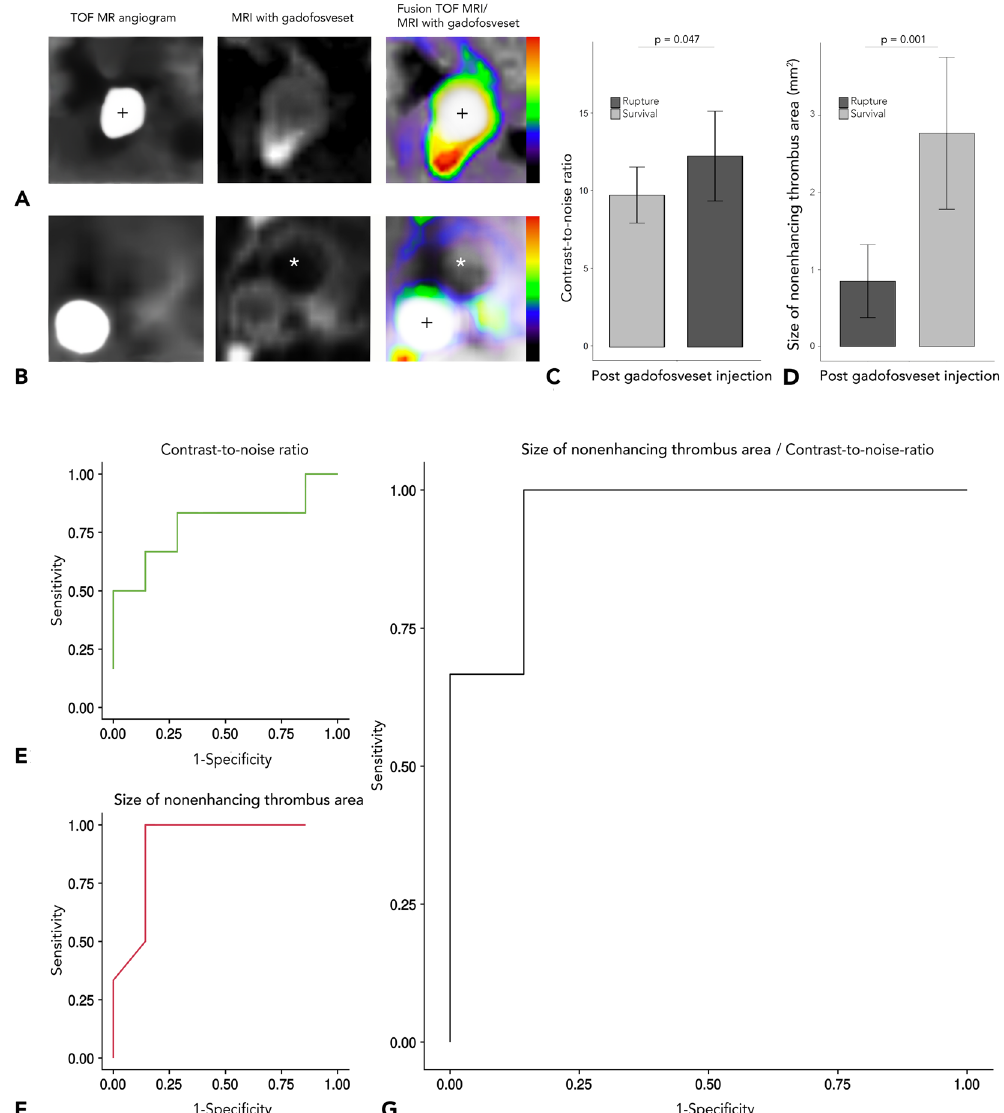
Figure 3. Assessment of aneurysm rupture in animals with stable aortic aneurysm and in animals with fatal aortic rupture (longitudinal study). ( A , B ) Cross-sectional time-of-flight (TOF) angiographies (on the left), delayed-enhancement sequences after administration of the albumin-binding probe gadofosveset (centre) and delayed-enhanced images fused with magnetic resonance TOF angiography (right). These images show the suprarenal abdominal aorta of an ApoE − / − mouse with AAA rupture ( A ) compared to a surviving ApoE − / − mouse. ( B ) In the fusion images on the right, blue signal indicates little enhancement, whereas red signal indicates increased enhancement following administration of an albumin-binding probe. We see, that ApoE − / − mice with AAA rupture show significantly increased signal enhancement, as measured by contrast-to-noise ratio (p = 0.047, see ( C ) and a smaller nonenhancing thrombus area (p = 0.001, see ( D )). ( E - G ) show ROC curves for contrast-to-noise ratio, size of nonenhancing thrombus and a combination of both. ( E ) We see, that use of the signal from the albumin-binding probe (contrast-to-noise ratio) predicted AAA rupture risk with 80% sensitivity and 70% specificity. ( F ) Size of the nonenhancing thrombus area predicted AAA rupture with 100% sensitivity and 78% specificity. ( G ) The combined used of both parameters had the highest accuracy for predicting aneurysm rupture with 100% sensitivity and 86% specificity compared with each parameter alone. Abbreviations: Gadofosveset: albumin-binding probe. * Nonenhancing intraluminal thrombus area; ROC: Receiver operating characteristic; TOF-MRA: time-of-flight magnetic resonance angiography; + : vascular lumen in arterial